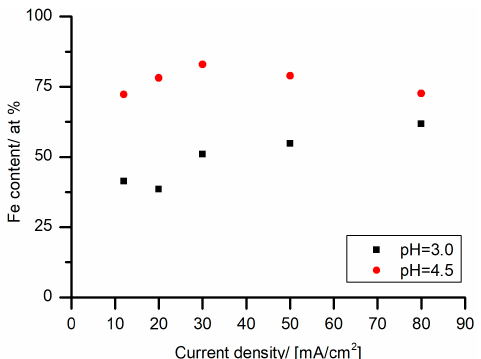
Figure 5. Change of the iron content in the deposits as a function of the current density. Samples were